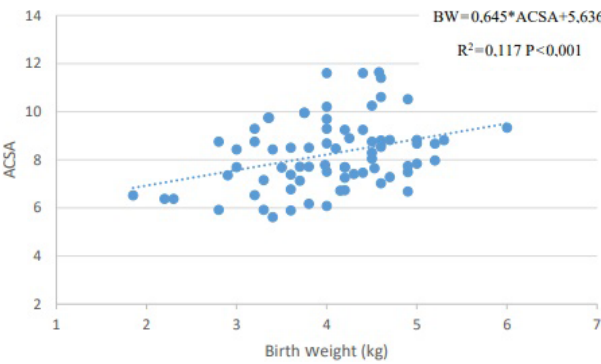
Figure 1. Correlation of lamb birth weight with the ACSA. 7 . 81 ± 0 . 19, respectively. There were no differences between parities in BW, CD and PE; however, PW, CN, CE and ACSA were affected by parity ( P< 0 . 05). Even if not significant, the lowest birth weight was observed in the group with a parity of 6 (3 . 54 ± 1 . 14 kg), and the highest birth weight in the group with a parity of 5 (4 . 10 ± . 82). ACSA was lowest in the group with a parity of 2 (7 . 33 ± . 99) and highest with a parity of 4 (8 . 61 ± 1 . 5). Also, CN was lowest in the group with a par- ity of 6. In the regression analysis, a significant relation was found between birth weight and ACSA at the p< 0 . 002 level ( y = 0 . 645 x + 5 . 636) (Fig. 1). Birth type affected BW, CN, CD ( p< 0 . 05), PW ( p< 0 . 001) and ACSA ( p< 0 . 01). The lowest BW (3 . 657 ± 0 . 22 kg) and CD (0 . 094 ± 0 . 01) and the highest PW (767 . 8 ± 40 . 3 g), CN (67 . 04 ± 4 . 8), PE (9 . 84 ± 0 . 9), CE (11 . 91 ± 0 . 91) and ACSA (9 . 46 ± 0 . 44) were determined in twin births.